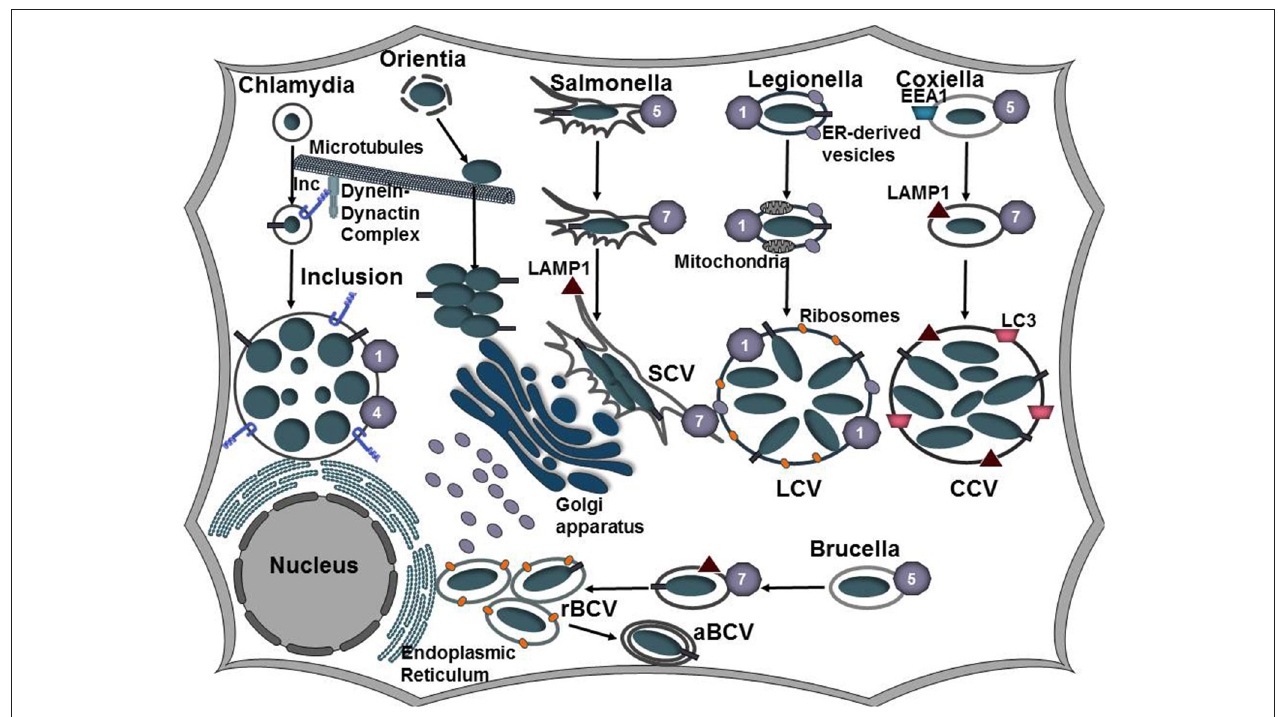
FIGURE 2 | Establishing a replicative niche. Following uptake by a host cell, intracellular bacteria manipulate the endocytic and secretory pathways of the host cell to establish a replicative niche. Coxiella, Salmonella, and Brucella associate with the endocytic pathways as evident by Rab5, Rab7, and LAMP1 that decorate the Coxiella -containing vacuole (CCV), Salmonella -containing vacuole (SCV), and Brucella -containing vacuole (BCV), respectively. As the CCV matures, it undergoes fusions with autophagosomes and acquires LC3. Vacuolar acidification induces expression of the C. burnetii Dot/Icm and the Brucella VirB type IV secretion systems. Following transient vacuolar acidification, the BCV is redirected to and fuses with the endoplasmic reticulum to form the rBCV. Some bacteria undergo interactions with autophagosomes (aBCV) as a possible exit mechanism. Salmonella replicates in the peri-Golgi region and induces the formation of tubular membranes, referred to as Salmonella -induced filaments (SIFs) that are enriched in LAMP1. L. pneumophila secretes Dot/Icm effector proteins to bypass the endocytic pathway and instead redirects ER-derived vesicles to the LCV. C. trachomatis also evades the endocytic pathway and inhibits fusions with lysosomes. Modification of the